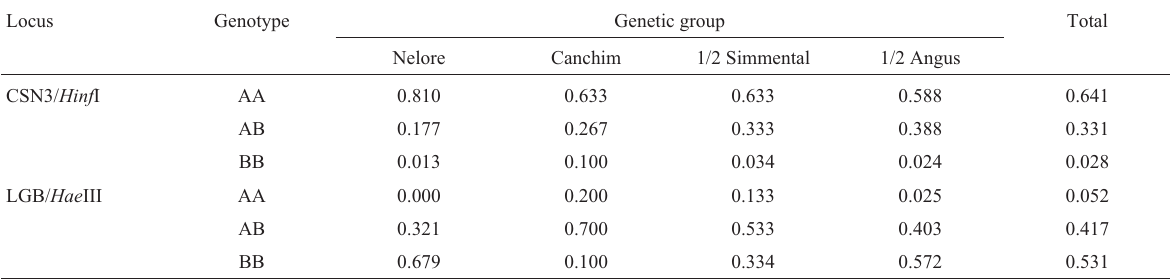
A,B significantly different allele frequencies within genetic groups (p < 0.05). a,b significantly different allele frequencies between genetic groups (p > 0.05). Table 2 - Genotype frequencies of the CSN3/ Hinf I and LGB/ Hae III loci obtained for the four genetic groups and for the sample as a whole.